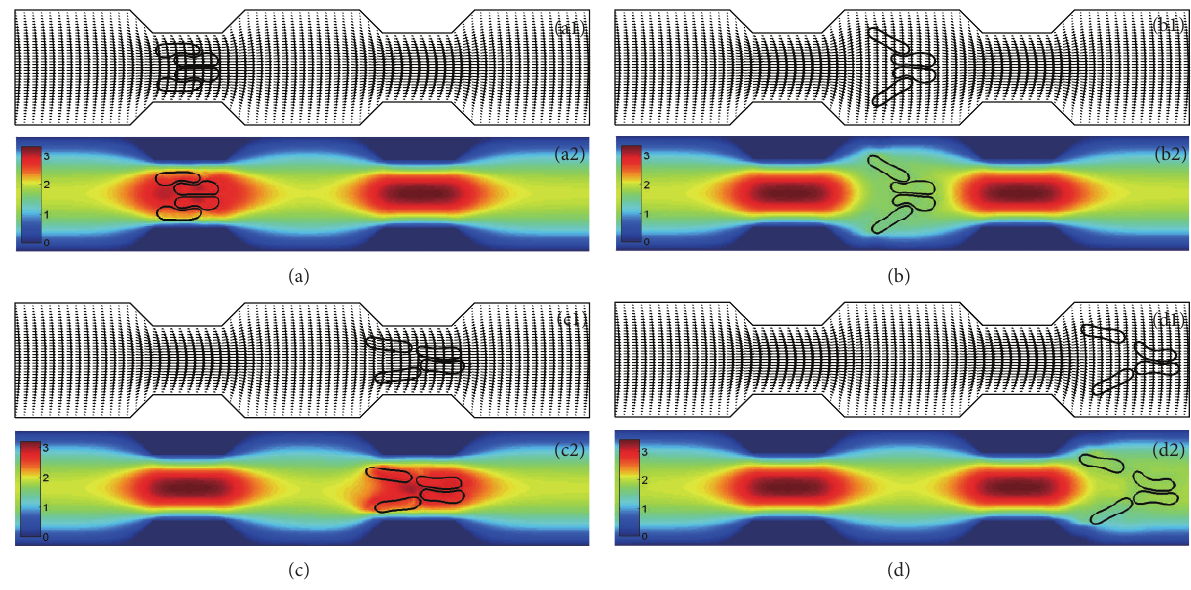
Figure 7: Motion and dissociation of a four-cell erythrocyte aggregate in a 12 𝜇 m stenotic channel at time instants (a) 𝑡 = 1.06 ms; (b) 𝑡 = 2.04 ms; (c) 𝑡 = 2.97 ms; and (d) 𝑡 = 3.89 ms. Velocity vectors (a1-d1) and axial velocity magnitude contours (cm/s) (a2-d2) are presented. The initial configuration for the aggregate is shown in Figure 1(d), and the aggregate is horizontally placed in the channel initially. The parameters used are 𝐷 𝑒 = 1.0 𝜇 J/m 2 , 𝑘 𝑏 = 5.0 × 10 −13 Nm.